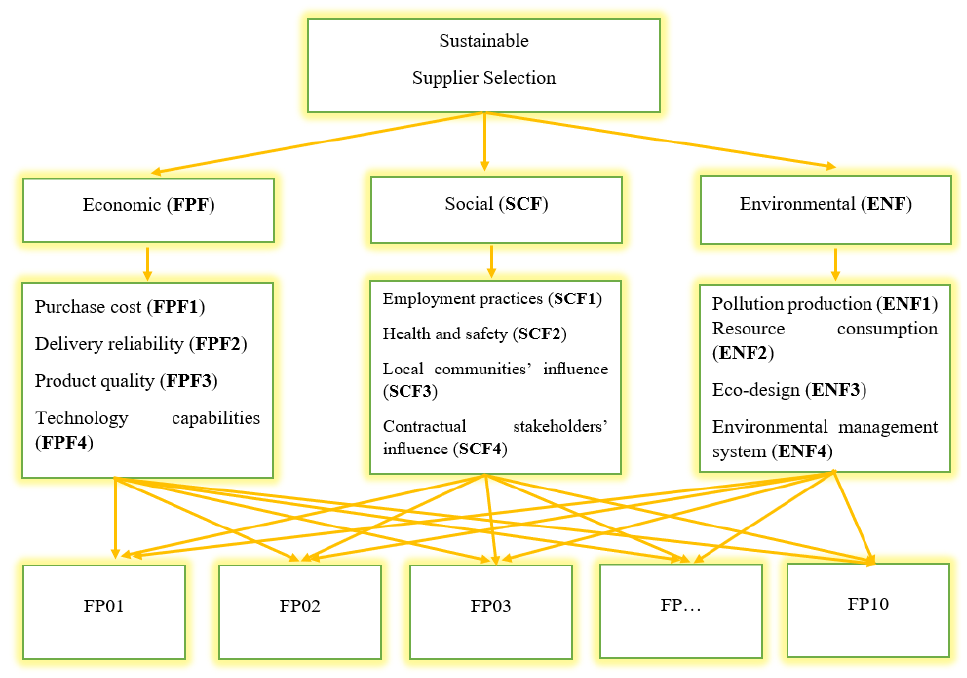
Figure 4. Structure of FAHP model.